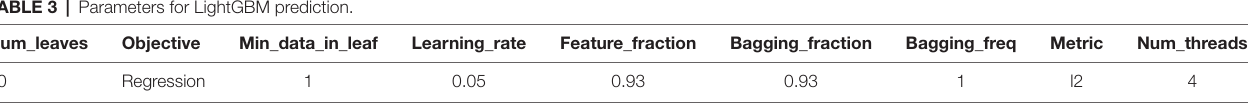
TABLE 3 | Parameters for LightGBM